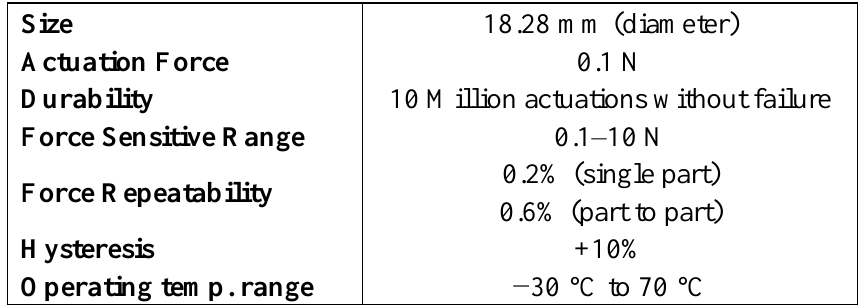
Table 1. Interlink Electronics Standard 402 FSR Main